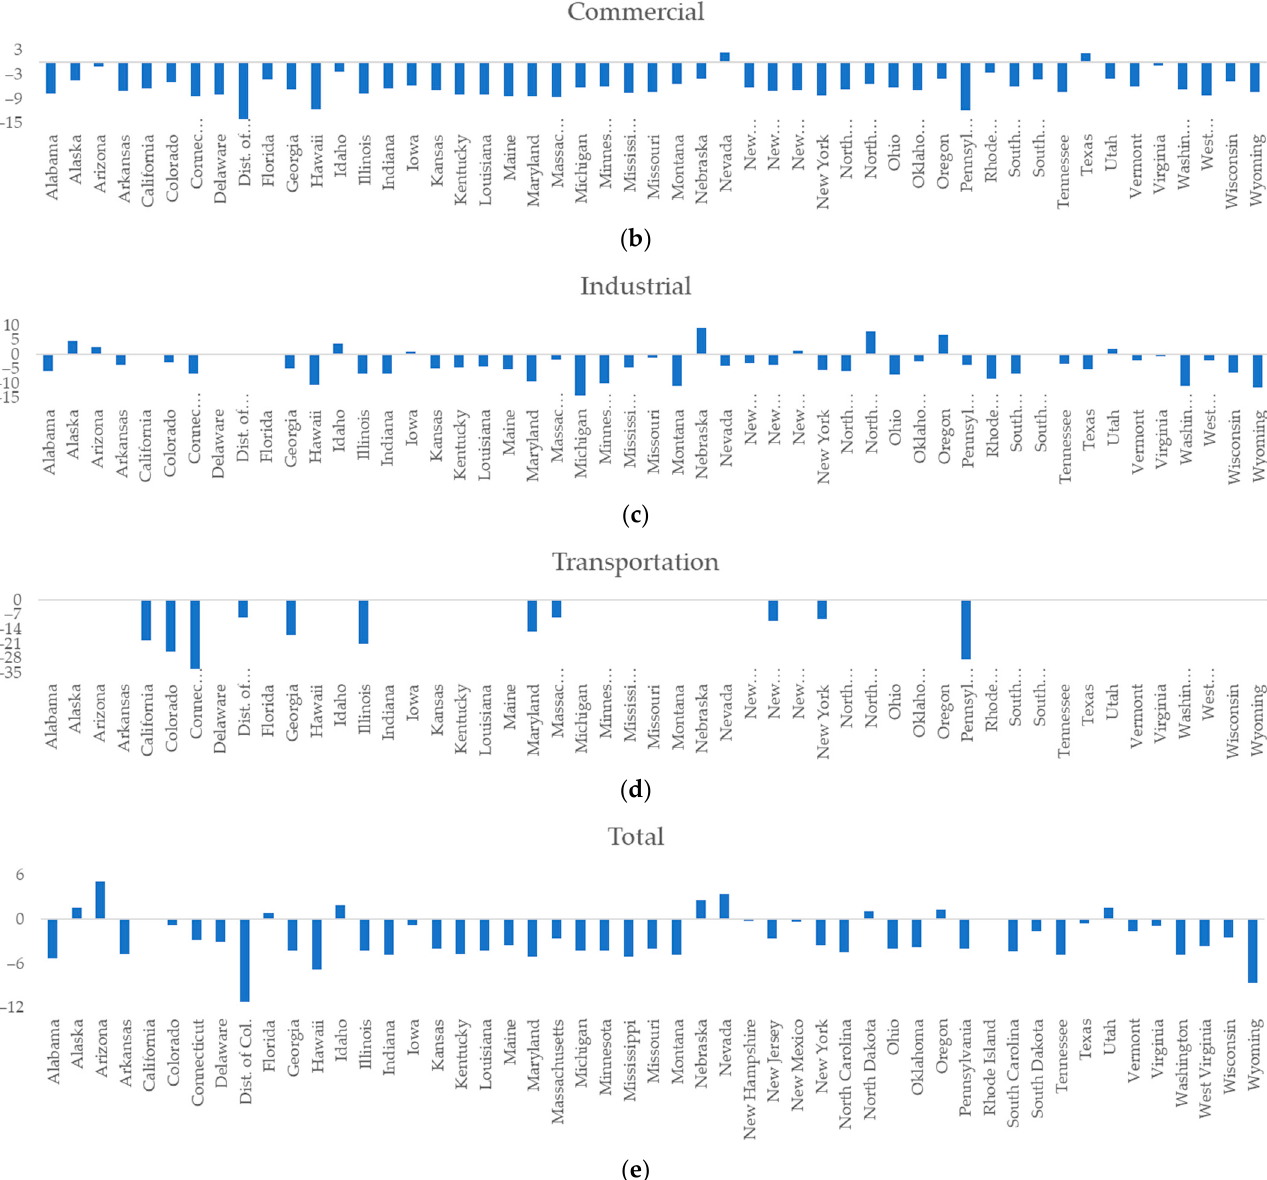
Figure 10. Change in 2020 sector electricity consumption by state [30].